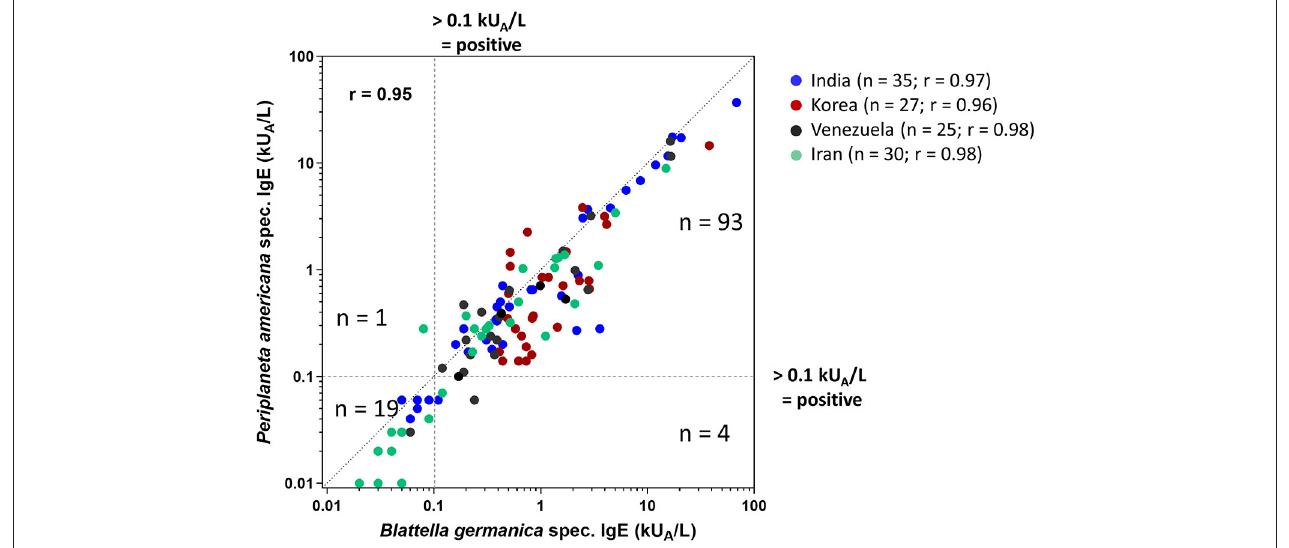
FIGURE 2 | Comparison of Periplaneta (i206)- and Blattella (i6)-specific IgE values in 117 patients (India, n = 35; Korea, n = 27; Venezuela, n = 25; Iran, n = 30) reporting cockroach allergy by ImmunoCAP testing (cutoff 0.1 kU A /L); r -values are indicated.